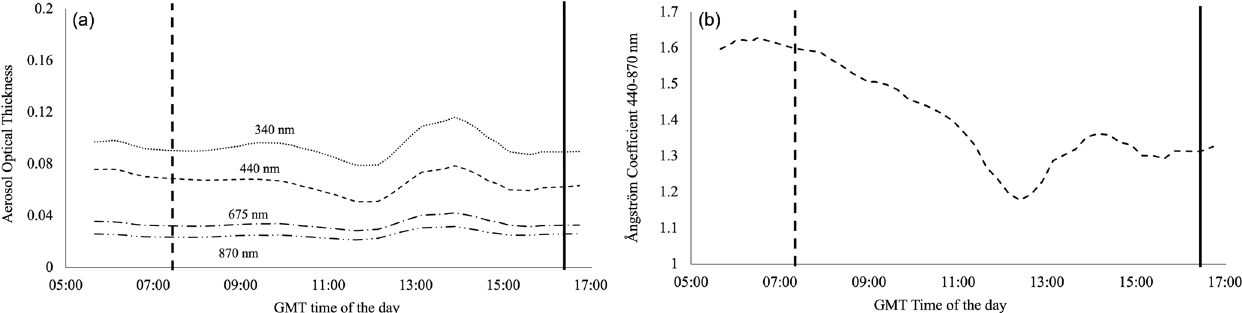
Figure 10. Daily variability in the aerosol optical thickness (a) and of the Ångström coefficient between 440–870nm (b) for the example of Fig. 9 (data acquired at the Aubiere site in July